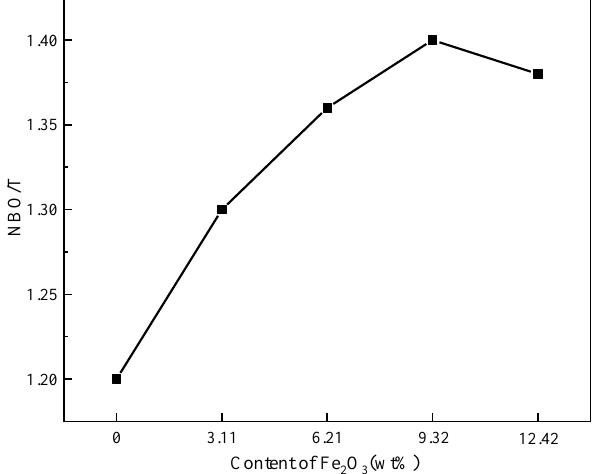
Figure 8. Deconvoluted spectra of the glasses using Gaussian function: ( a ) 0 wt% Fe 2 O 3 ; ( b ) 3.11 wt% Fe 2 O 3 ; ( c ) 6.21 wt% Fe 2 O 3 ; ( d ) 9.32 wt% Fe 2 O 3 ; ( e ) 12.42 wt% Fe 2 O 3 . The calculation results of NBO/T are shown in Figure 9. With the increase in Fe 2 O 3 content, the NBO/T in the precursor first increases and then decreases, reaching a maxi- mum at an Fe 2 O 3 content of 9.32 wt%. It can be seen that the degree of crystal network connectivity shows a trend of decreasing and then increasing. According to the network connectivity – depolymerization reaction, shown in Equation (3):